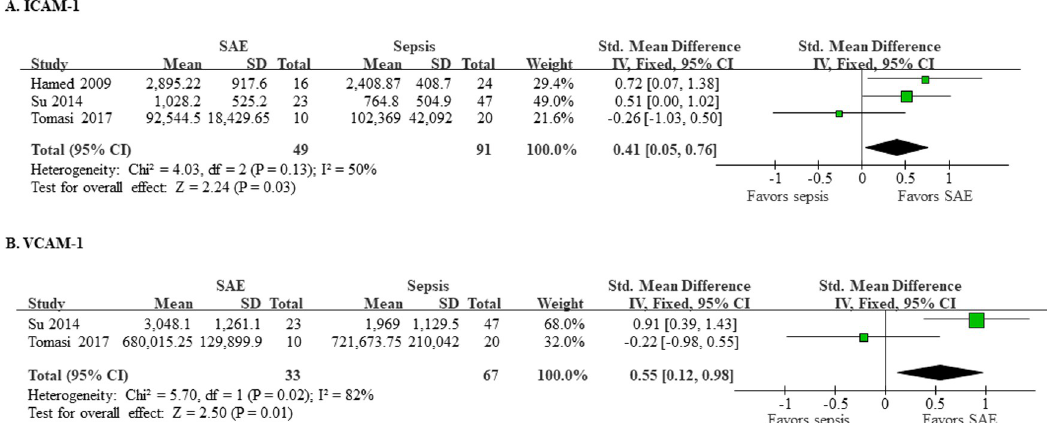
Fig 2. Levels of ICAM-1 and VCAM-1. Three studies (140 patients) reported data for ICAM-1 (A), and two studies (100 patients) reported data for VCAM-1 (B). The pooled mean concentration of ICAM-1 was higher in patients with SAE compared to the patients with sepsis alone (SMD 0.41; 95% CI 0.05–0.76; p = 0.03), and there was moderate heterogeneity (I 2 = 50%) between studies. The pooled mean concentration of VCAM-1 was higher in patients with SAE compared to the patients with sepsis alone (SMD 0.55; 95% CI 0.12–0.98; p = 0.01), and the heterogeneity between studies was high (I 2 = 82%).